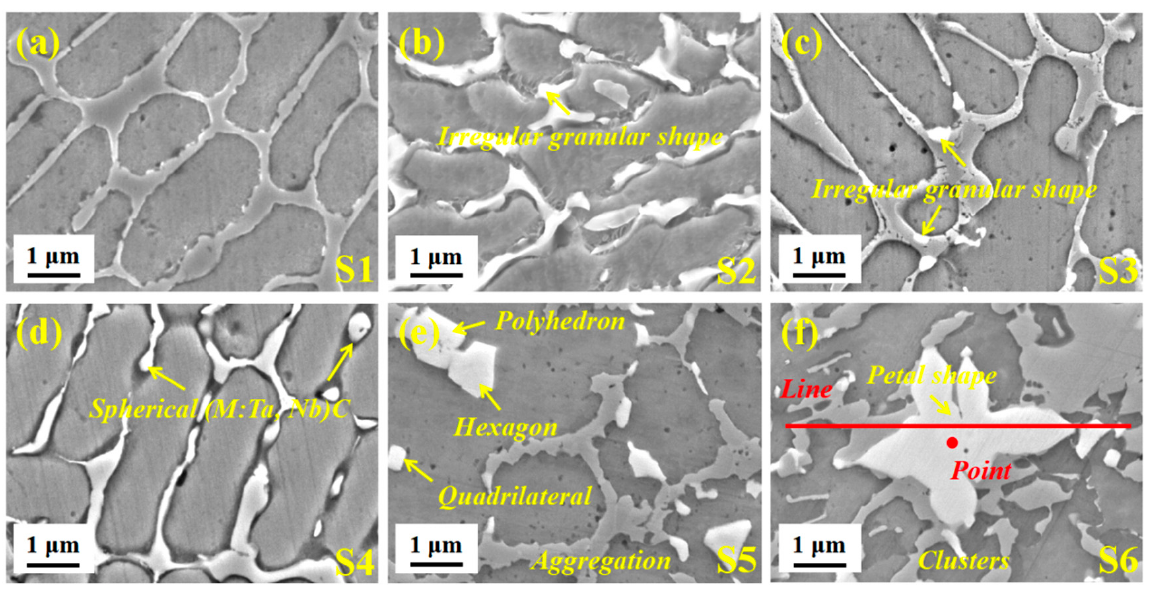
Figure 4. Typical SEM images of composite coating with different ceramic micro-particle content. ( a ) S1; ( b ) S2; ( c ) S3; ( d ) S4; ( e ) S5; ( f ) S6.